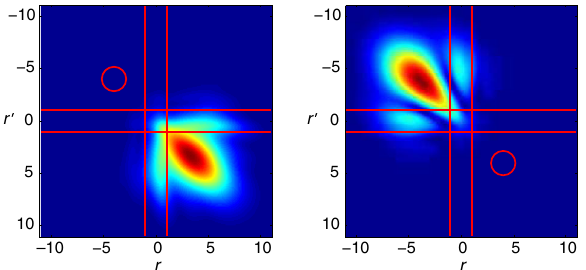
FIG. 14. The forward and reverse processes. The density operators of the combined control and energy reservoir particle in the position representation (the absolute values of the matrix elements) at the end of the forward (left panel) and reverse (right panel) processes. The pairs of horizontal and vertical lines show the borders of the interaction region. The red circles indicate the positions of the initial states G β ˆ ð Q i þ Þ and G β ˆ ð Q f þ Þ for the K K CE CE initial and final measurement operators Q i þ ¼ j − 4 þ 2 i ih − 4 þ CE 2 i j , Q f þ ¼ j 4 þ 2 i ih 4 þ 2 i j . The error in the approximate fluc- CE tuation relation is small (approximately 1 . 6 × 10 − 8 ), which corresponds to the fact that the measurement operators are well separated from the interaction region. One should compare this FIG. 13. Approximate factorization. To assess the quality with the final wave packets, where one can clearly see that these ˆ 1 ⊗ of the approximate factorization, we evaluate d H ˆ ð S 0 have significant weights within the interaction region. This K;E 0 σ z = 2 ˆ 1 ⊗ j α ih α jÞ (green curve), ð j α ih α jÞ (red curve), d H ˆ S 0 K;E 0 σ x = 4 operators, rather than the final states, are important for the ˆ 1 ⊗ j α ih α jÞ (blue curve) for α ≔ r þ 2 i , with and d H ˆ ð S 0 K;E 0 ¯ n ð ry 0 Þ · ¯ σ = 2 quality of the approximation. One can also note that the final r ∈ ½ − 10 ; 10 (cid:2) . The dotted black lines correspond to the borders of states are not mirror images of each other. Hence, the symmetry the interaction region. The red circles are the positions of discussed in Appendix I 1 does not imply that the wave packets of the coherent states that give the measurement operators Q i þ ¼ the forward and reverse processes have to be symmetric images of CE each j − 4 þ 2 i ih − 4 þ 2 i j and Q f þ ¼ j 4 þ 2 i ih 4 þ 2 i j . CE